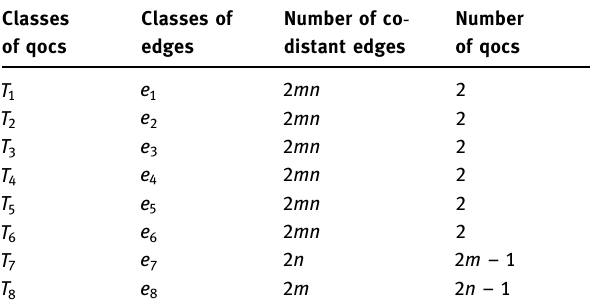
Table 1: Co - distant edges in